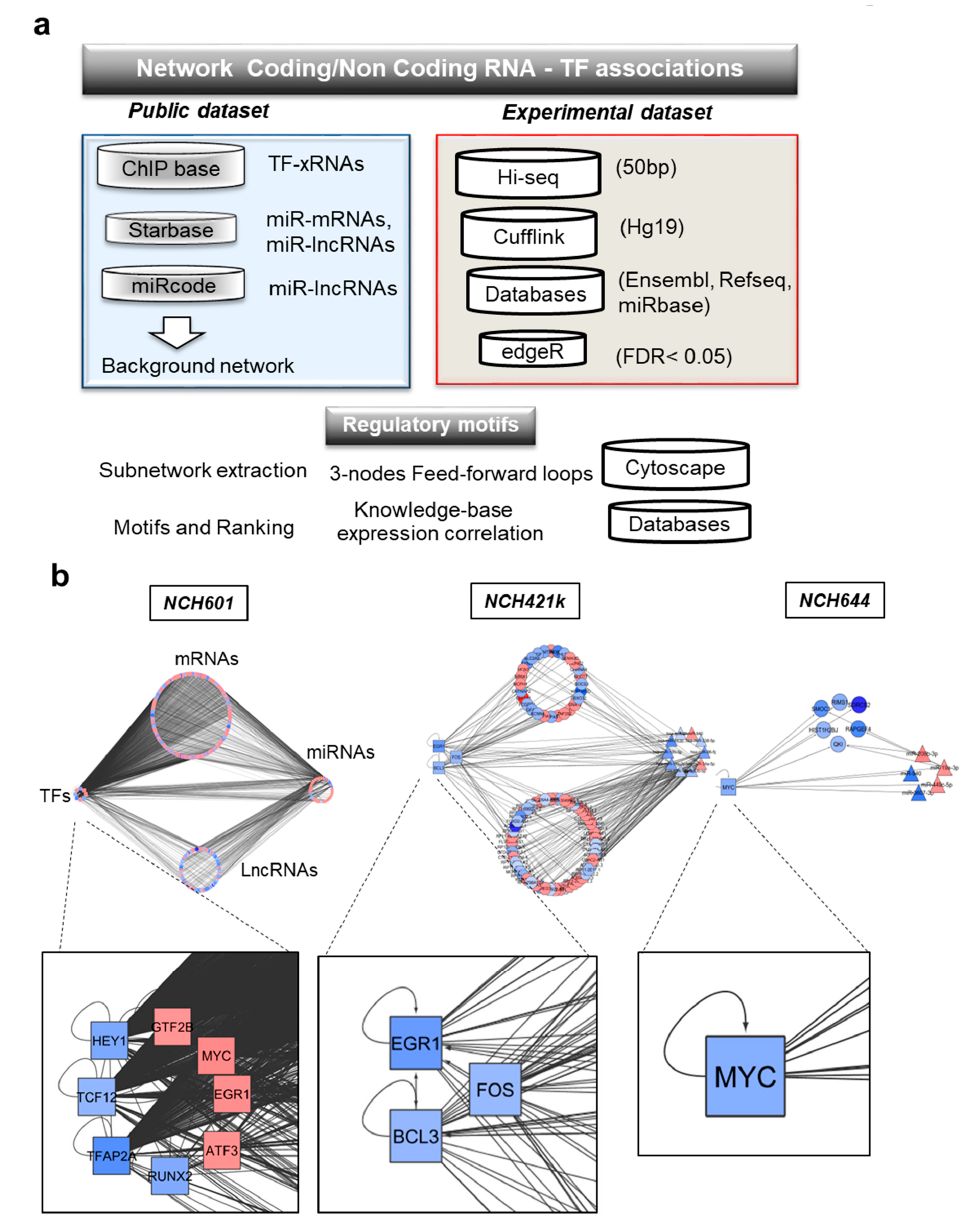
Figure 4. Systems approaches used for the generation of the RNA interactome and gene regulatory networks induced by TMZ in GBM. ( a ) Overview of the analysis pipeline, ( b ) gene regulatory networks representing the molecular associations between different RNA biotypes in different GSCs: mRNAs, miRNAs, lncRNAs, and transcription factors (TFs). Up- and downregulated RNAs are shown in red and blue, respectively. Different node shapes distinguish RNA biotypes: TF: square, miRNA: triangle, mRNA: circle, lncRNA: hexagon.